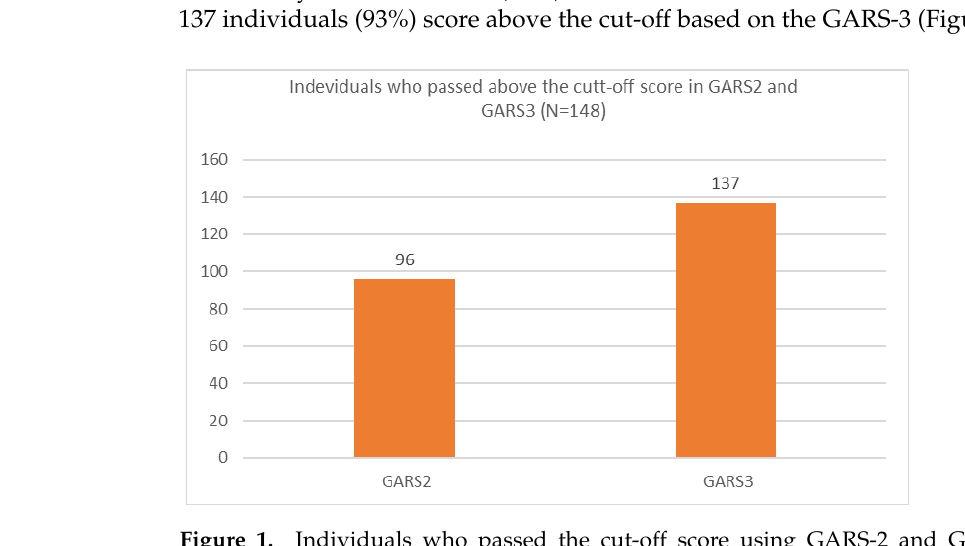
Figure 1. Individuals who passed the cut-off score using GARS-2 and GARS-3 scale in the present study.